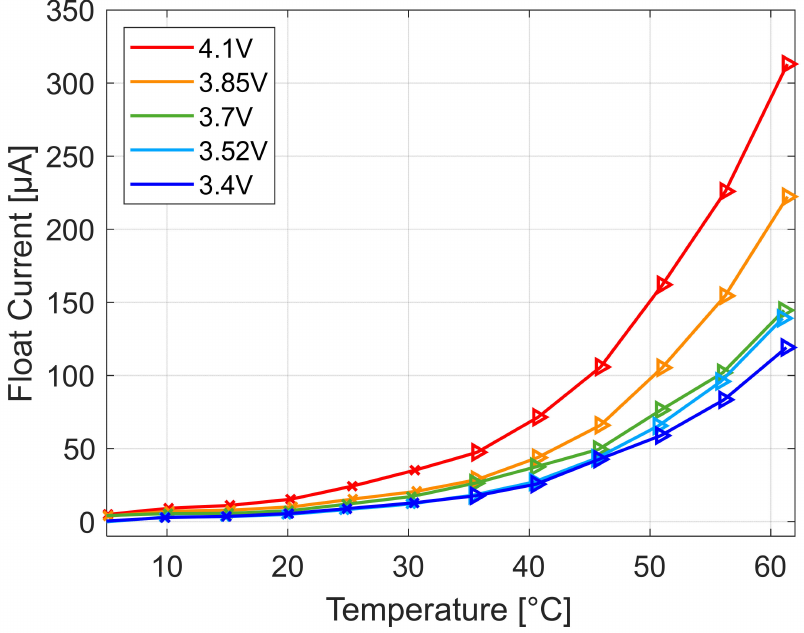
Figure 7. Float current over temperature for five different cell potentials with the expected uncertainty by the measurement. The data are fitted with an